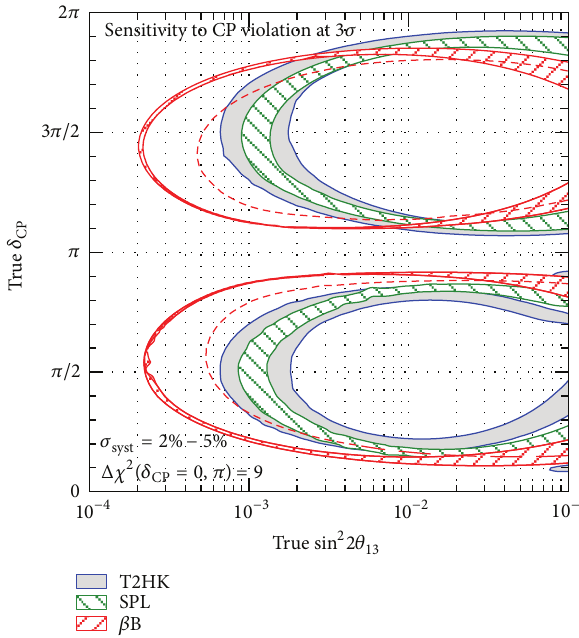
Figure 15: CP violation discovery at 3𝜎 as a function of 𝛿 for a betabeam, SPL, and T2HK. The combination of SPL and a betabeam is also shown. The betabeam lines correspond to 5.8(2.2) × 10 18 decays per year of 6 He ( 18 Ne). Details of the simulations can be found in [68]. The width of the bands reflects the change of the systematic errors from 2% to 5%. The dashed curves are obtained for a betabeam flux reduced by a factor of